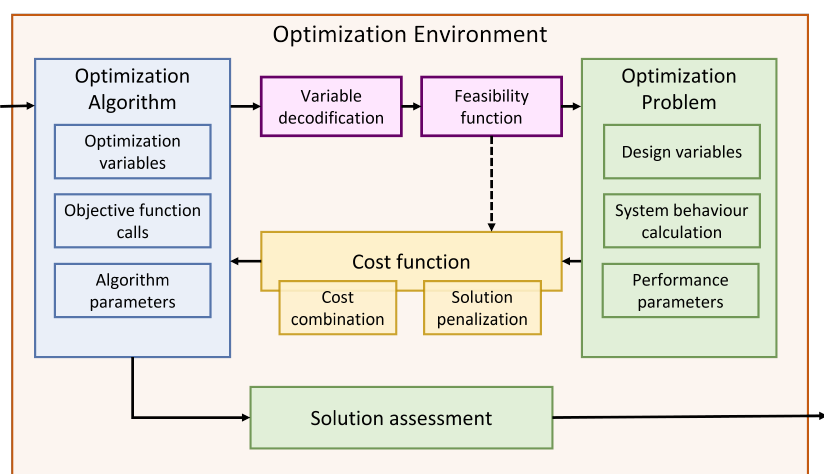
Figure 4. Optimization environment: it is composed by all the elements involved in the optimization process and it guarantees the quality of the final